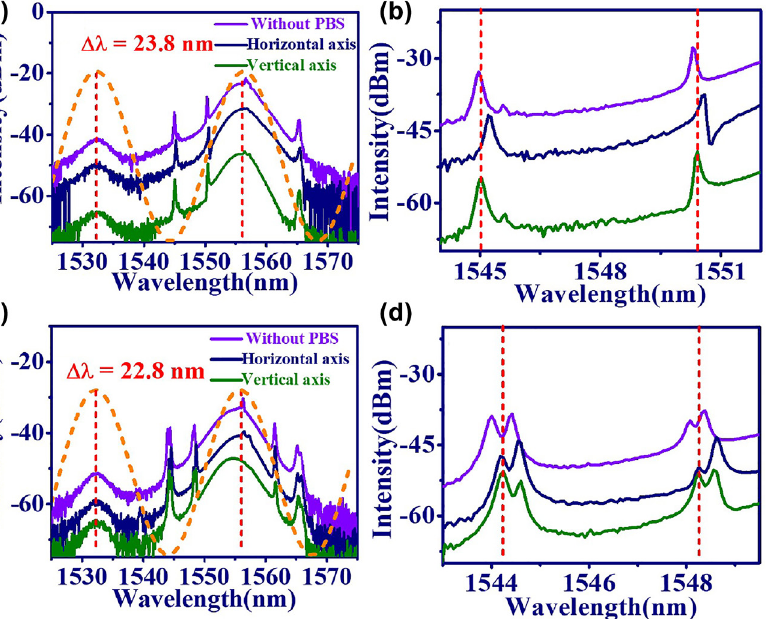
Figure 5: Dual wavelength GVLVSs from EDFL based on GO/PVA film. (a) Optical spectrum and (b) zoomed in optical spectrum of Kelly sidebands with 35 cm long PMF. (c) Optical spectrum and (d) zoomed in optical spectrum of Kelly sidebands with 40 cm long PMF (without PBS: purple line, horizontal axis: navy line, and vertical axis: green line). (Orange dashed line in (a) and (c) shows the estimated transmission spectrum of invisible filter by Eqs. (1) and